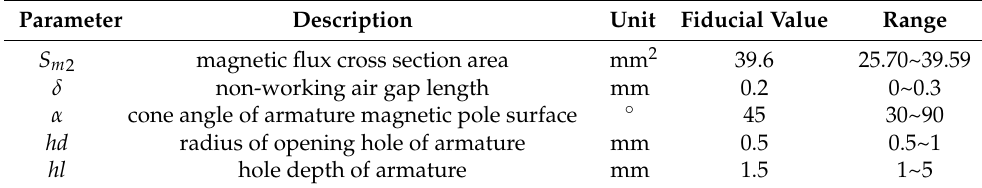
Table 3. Variation range of key structural parameters.